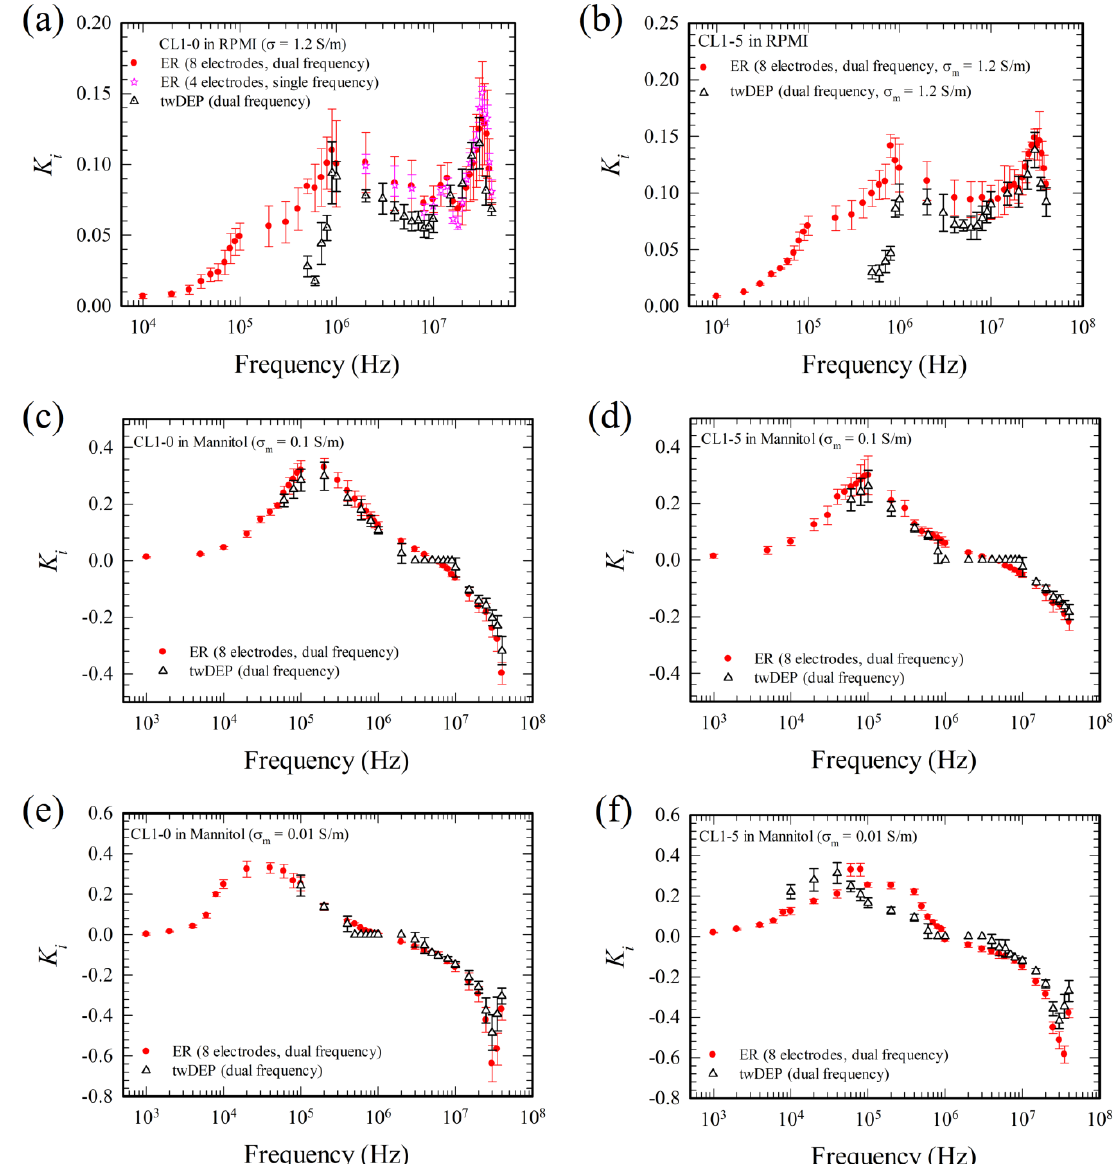
Figure 8. Comparison of the present measurements with experimental results in the literature for CL1-0 and CL1-5 cells, respectively, in ( a ) and ( b ) RPMI solution with σ m ≈ 1.2 S / m, ( c ) and ( d ) mannitol solution with σ m ≈ 0.1 S / m, and ( e ) and ( f ) mannitol solution with σ m ≈ 0.01 S / m. Graphic notations are the same as those in Figure 7.